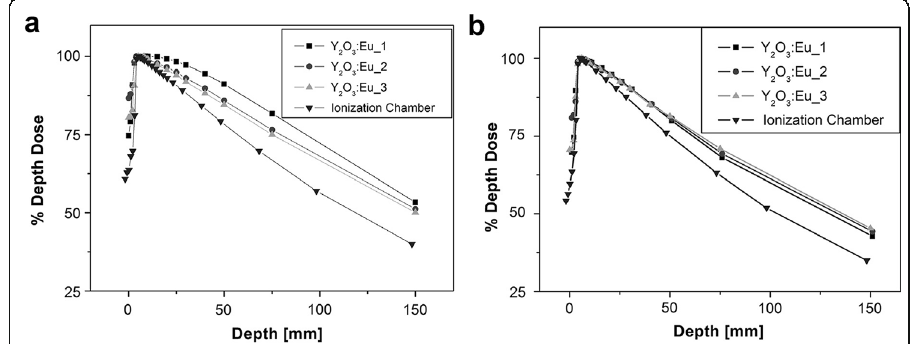
Fig. 8 The PDD curves from Y 2 O 3 :Eu-based FOD compare to that of a standard IC under 60 Co irradiation. Surface to source distance is 80 cm and the irradiation field is set to a 10 × 10 cm 2 and b 5 × 5 cm 2 respectively [58]. Different phosphor coating thickness is